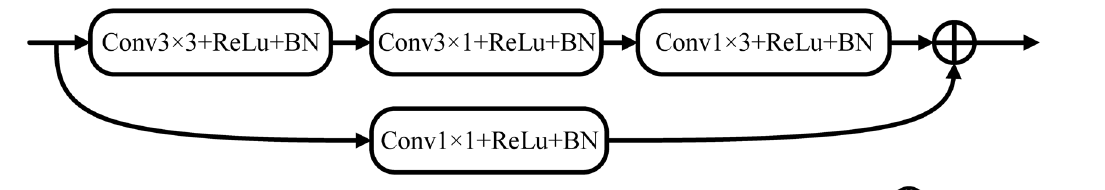
Figure 2. Encoding block.